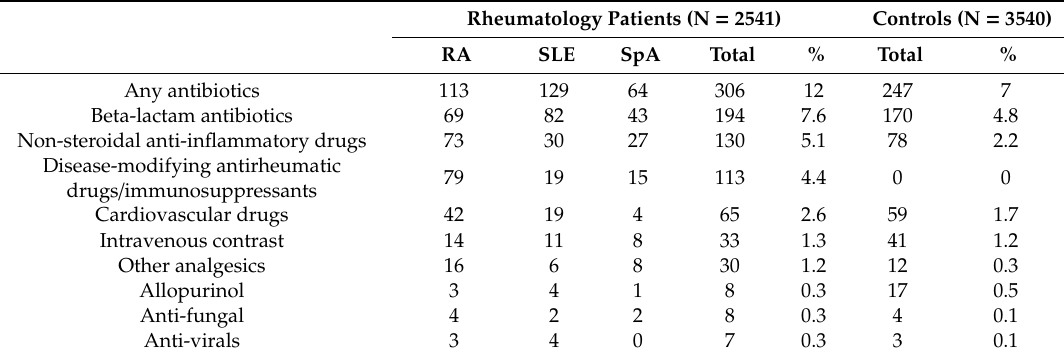
Table 2. Frequency of different classes of reported drug allergies (DA).